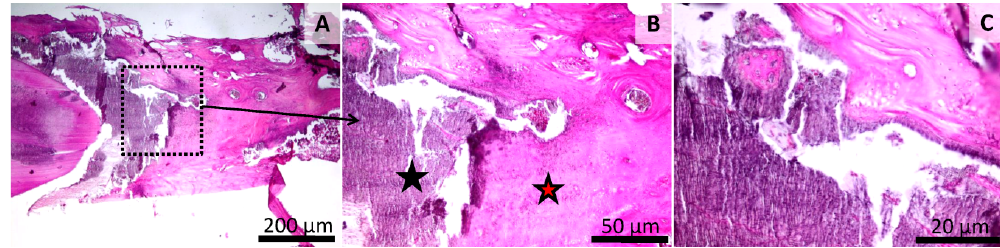
Figure 9. Histology of the mandibular defect. Dental cement Group (LC1) (Group 3), irregular aspect of the bone surface ( A , B , C ). Intramembranous and endochondral bone formation (red star) ( B , C ). Finely granular test material near the newly formed bone (black star) ( B , C ). HE stain, Scale bar = 200 µ m ( A ), Scale bar = 50 µ m ( B ), Scale bar = 20 µ m ( C